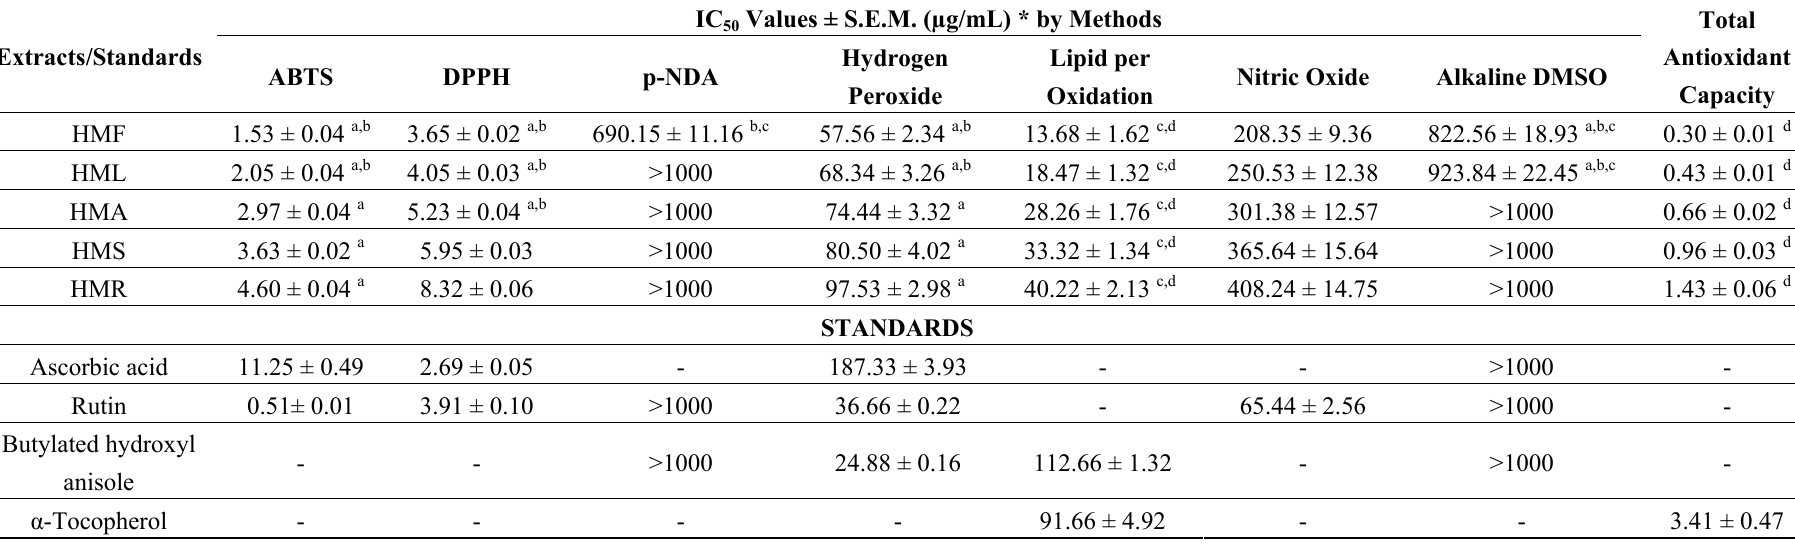
* The average of three determinations; values are the mean ± S.E.M. For the deoxyribose method, the IC 50 values of all the extracts were >1000 μg/mL. For total antioxidant capacity, the values are expressed as the equivalent of ascorbic acid per gram of extract. a p < 0.05, b p < 0.05, c p < 0.05, d p < 0.05 between extracts and standards of ascorbic acid, rutin, butylated hydroxyl anisole and α-tocopherol,